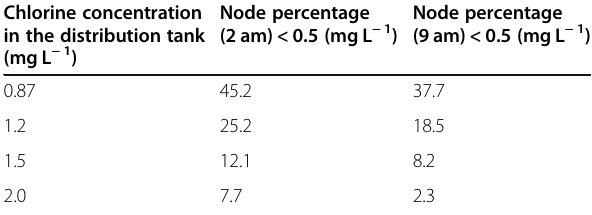
Table 5 Percentage of nodes with chlorine concentration < 0.5 mg L − 1 after simulating different concentrations (0.87, 1.2, 1.5 and 2 mg L − 1 ) in the distribution tank Chlorine concentration in the distribution tank (mg L − 1